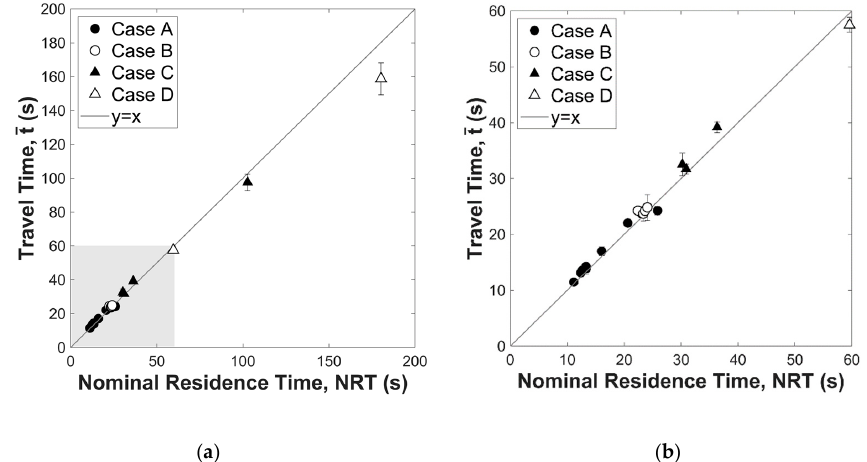
Figure 8. Relationship between system’s measured travel time and Nominal Residence Time (NRT; Cases A–D). ( a ) time range 0 to 200 s, ( b ) time range 0 to 60 s (shaded area in ( a )).